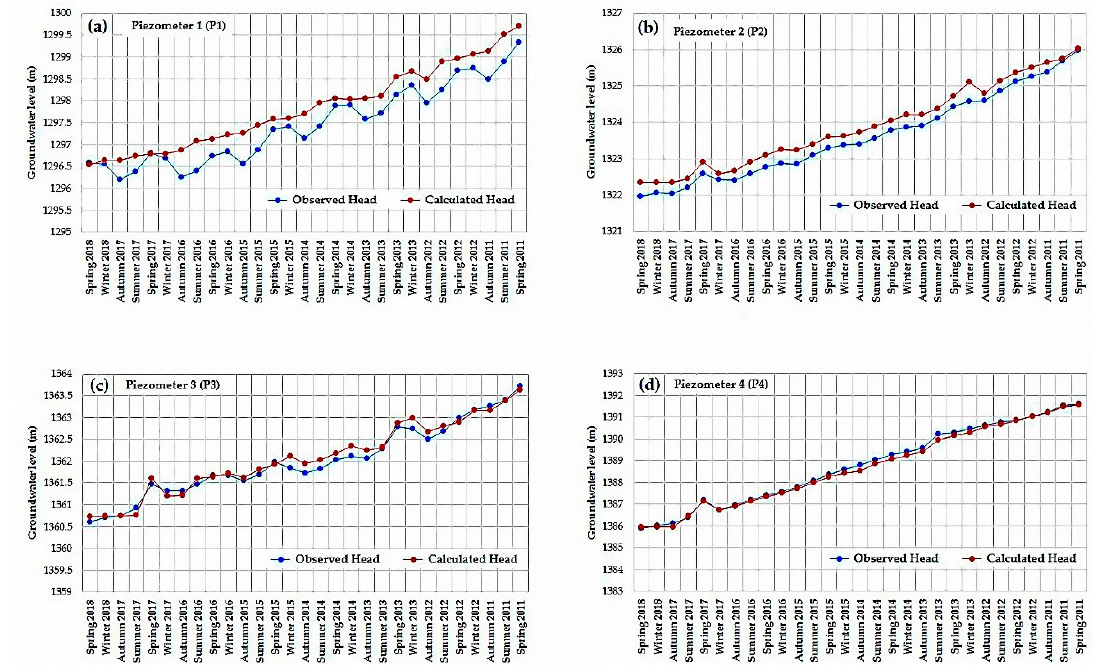
Figure 16. The results of semi-transient calibration of the model, Birjand groundwater level changes as well as observed and calculated head values for the four selected piezometers include ( a ) piezometer 1; ( b ) piezometer 2; ( c ) piezometer 3; and, ( d ) piezometer 4, over a period of about 7 years as seasonal.